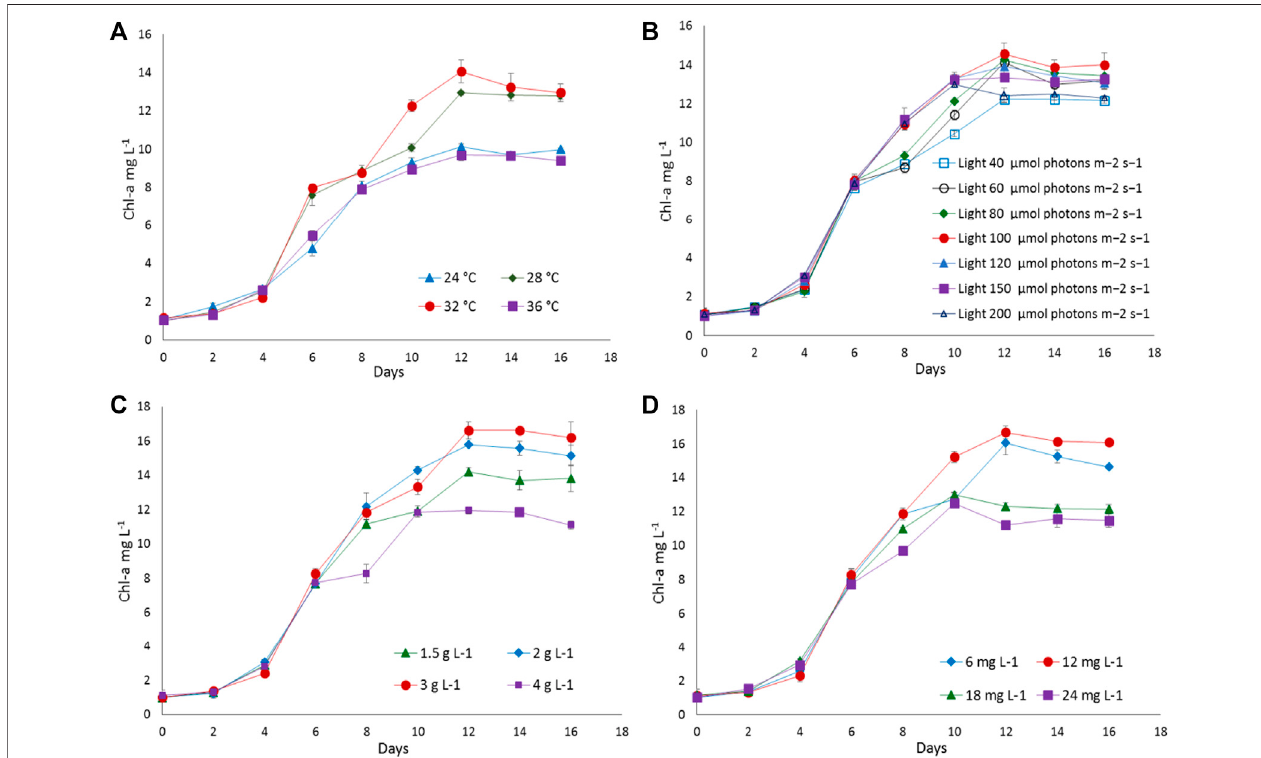
FIGURE 3 | The growth response of Deserti fi lum sp. to different (A) temperatures, (B) lightintensities, (C) sodium nitrate concentrations, and (D) ferric ammonium citrate concentrations. Error bars represent ± SD (n (cid:2) 3).